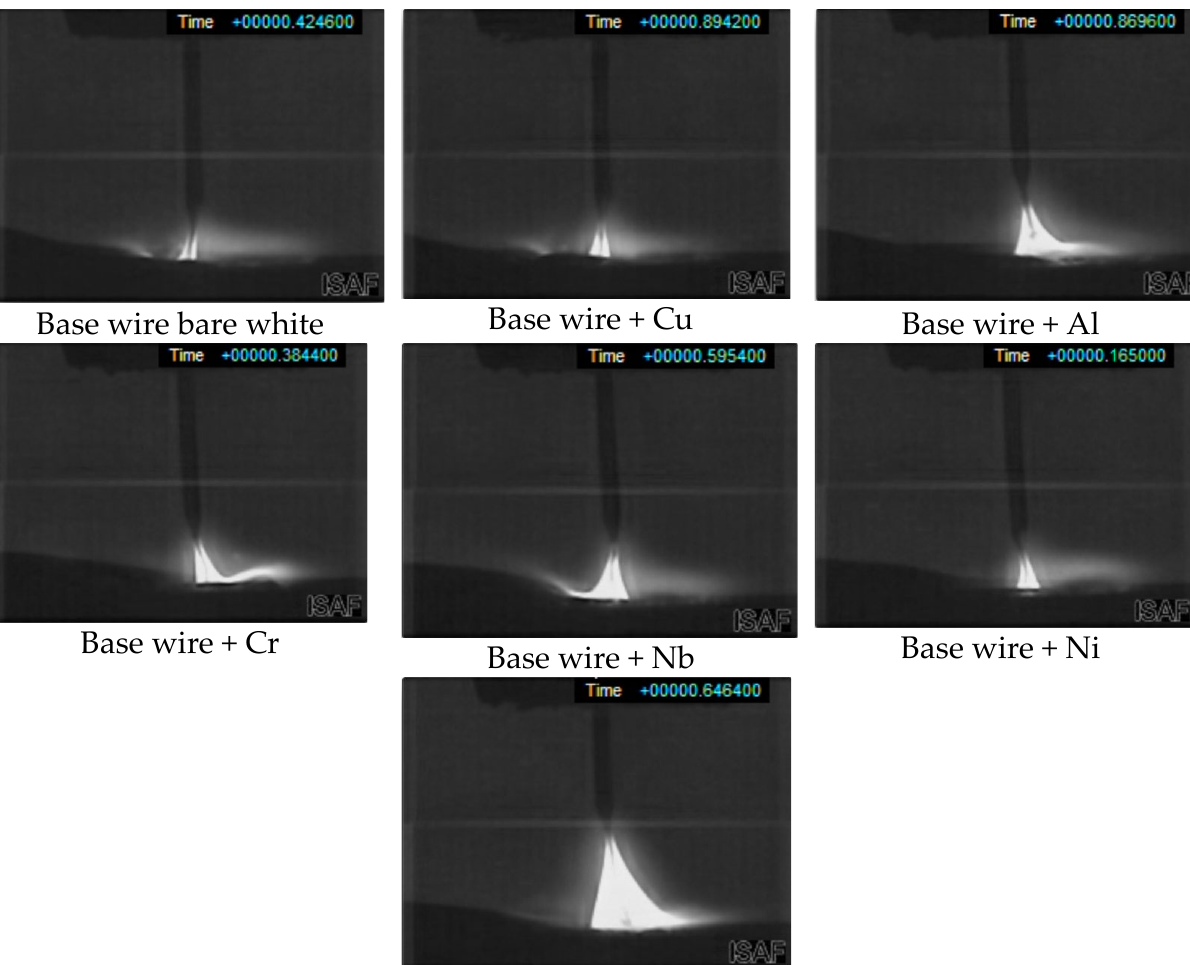
Figure 5. Arc recordings.